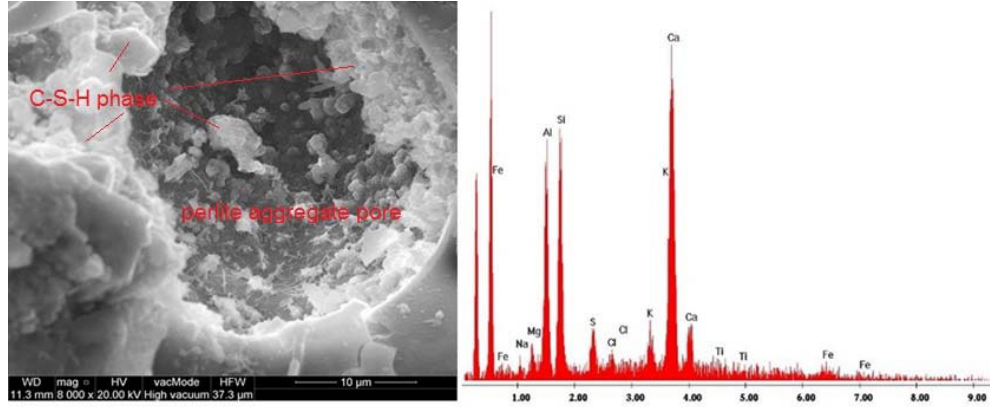
Figure 10. Microstructure of SCC C5P0 and EDS elemental analysis–perlite aggregate pores filled with C-S-H phase (×8000).